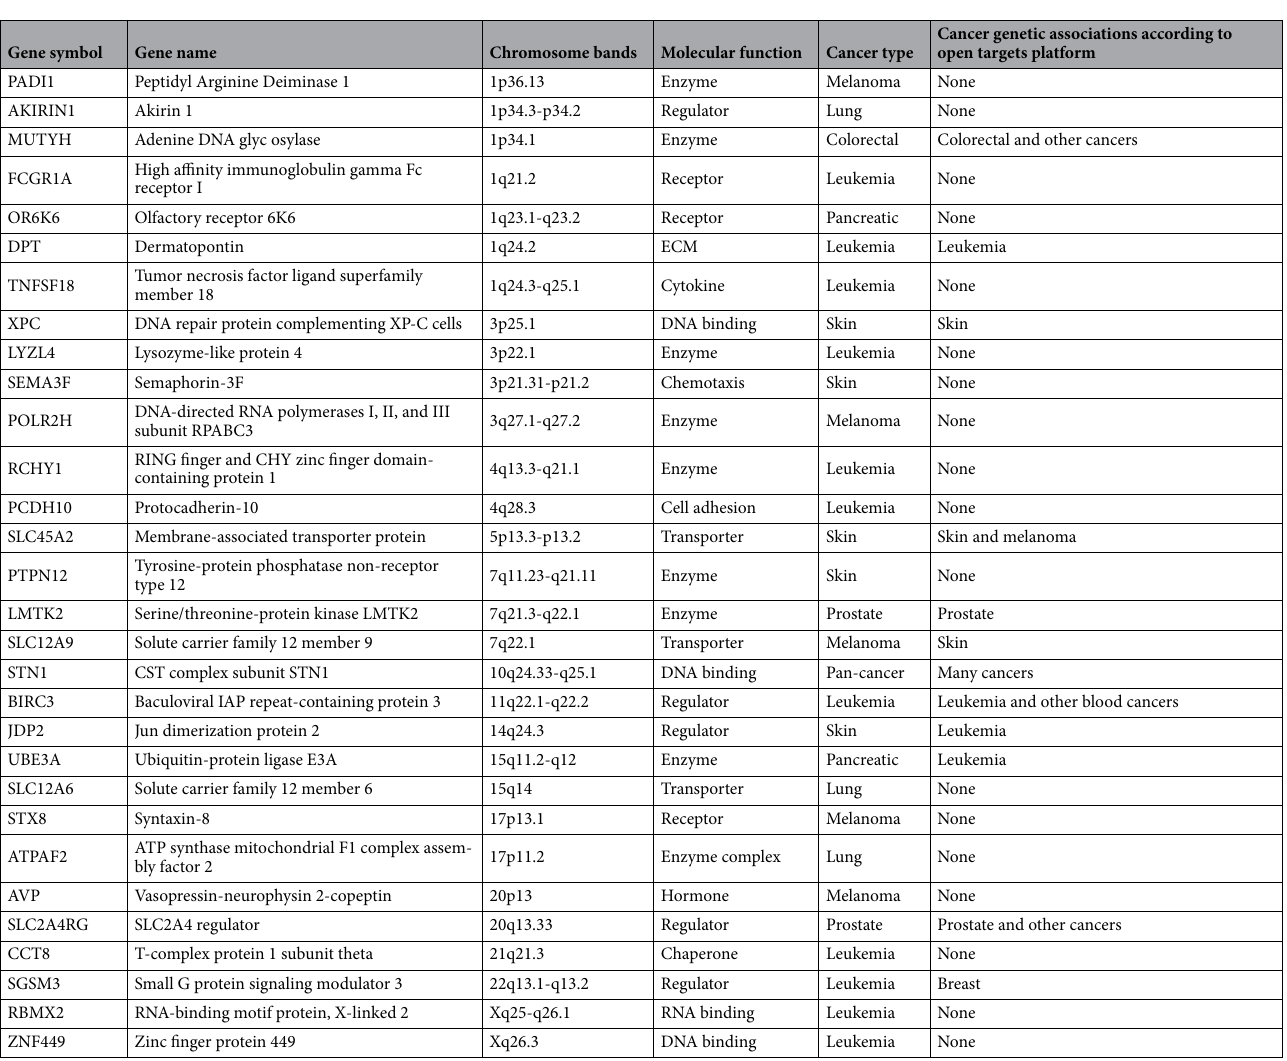
Table 3. Recessive cancer predisposition